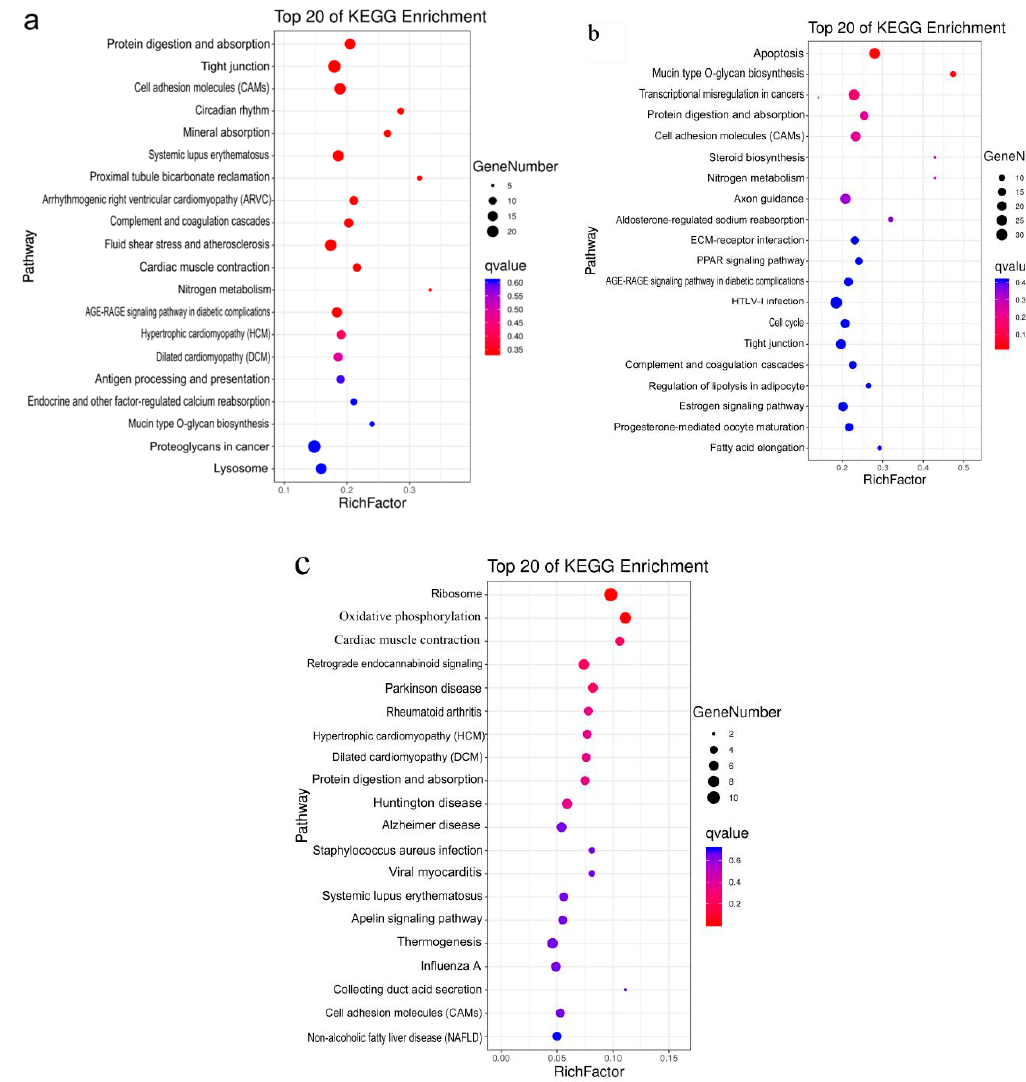
Figure 5. Top 20 KEGG enrichment pathways of DEGs. ( a ) KEGG enrichment of DEGs in D135 vs. D105. ( b ) KEGG enrichment of DEGs in DR135 vs. D105. ( c ) KEGG enrichment of DEGs in DR135 vs. D135. The x-axis represents rich factor and the y-axis represents the KEGG pathways.